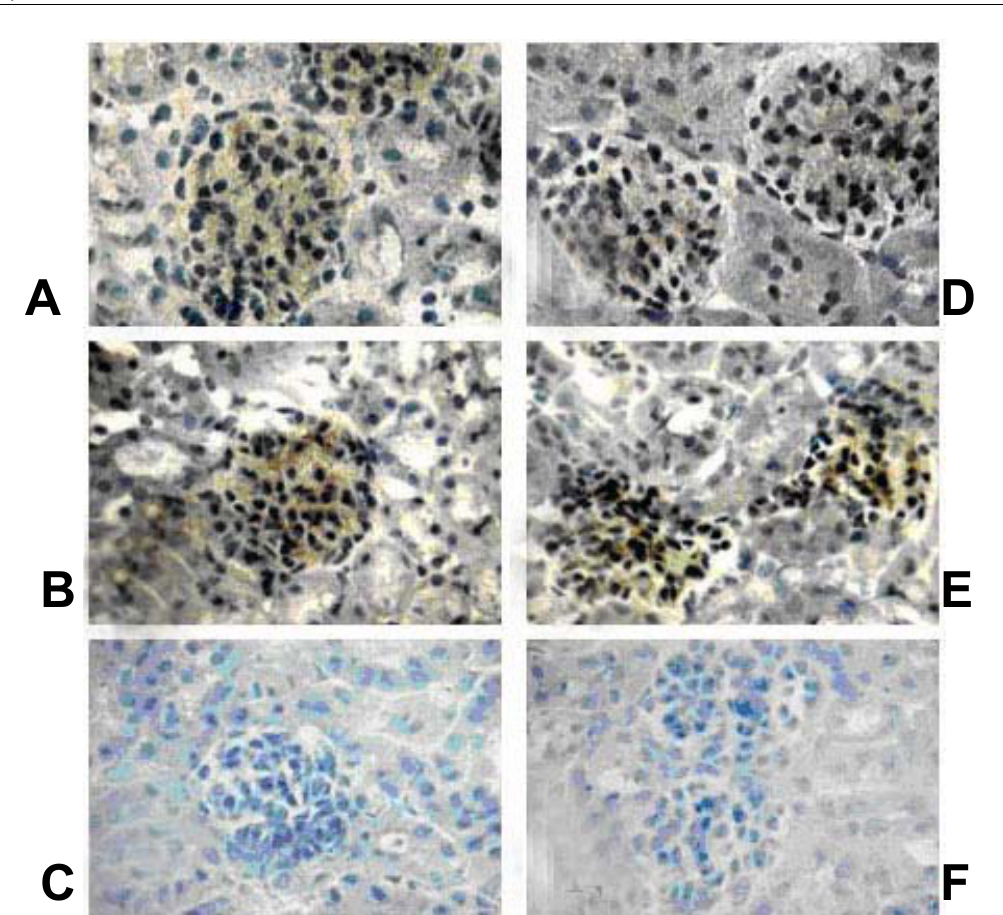
Figure 1. Weak glomerular-positive staining to IL-6 at day 2 ( A ) and more intense at day 7 ( B ). Frame D shows weaker positive staining for TNF- α than the intensity observed at day 7. Frames C and F are respectively controls for IL-6 and TNF- α ( A , B and C revealed by DAB, objective